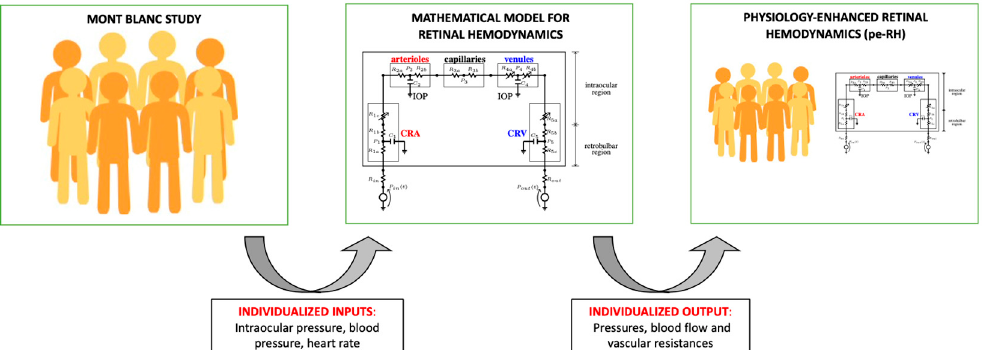
Figure 1. Schematic of the physiology-enhanced retinal hemodynamics ( pe-RH ) analysis. Starting from clinical data ( left ) of intraocular pressure, blood pressure, and heart rate from the Mont Blanc Study, the mathematical model for retinal hemodynamics ( center ) was used to predict pressures, blood flow, and vascular resistances in the retina as individualized outputs, resulting in the pe-RH dataset ( right ).